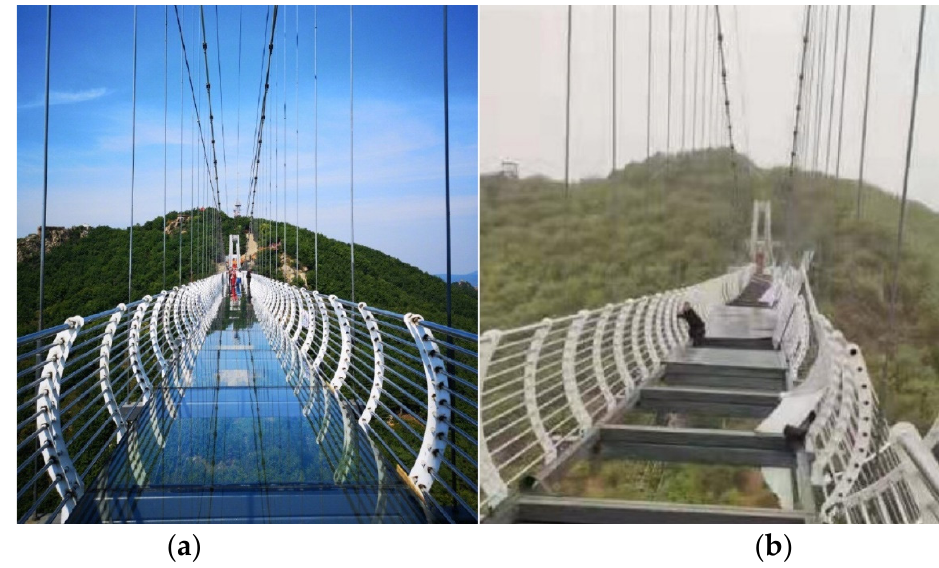
Figure 6. Example of accident in a 100 m high bridge in China due to wind loading: ( a ) initial configuration for the intact bridge and ( b ) post-accident con fi guration.